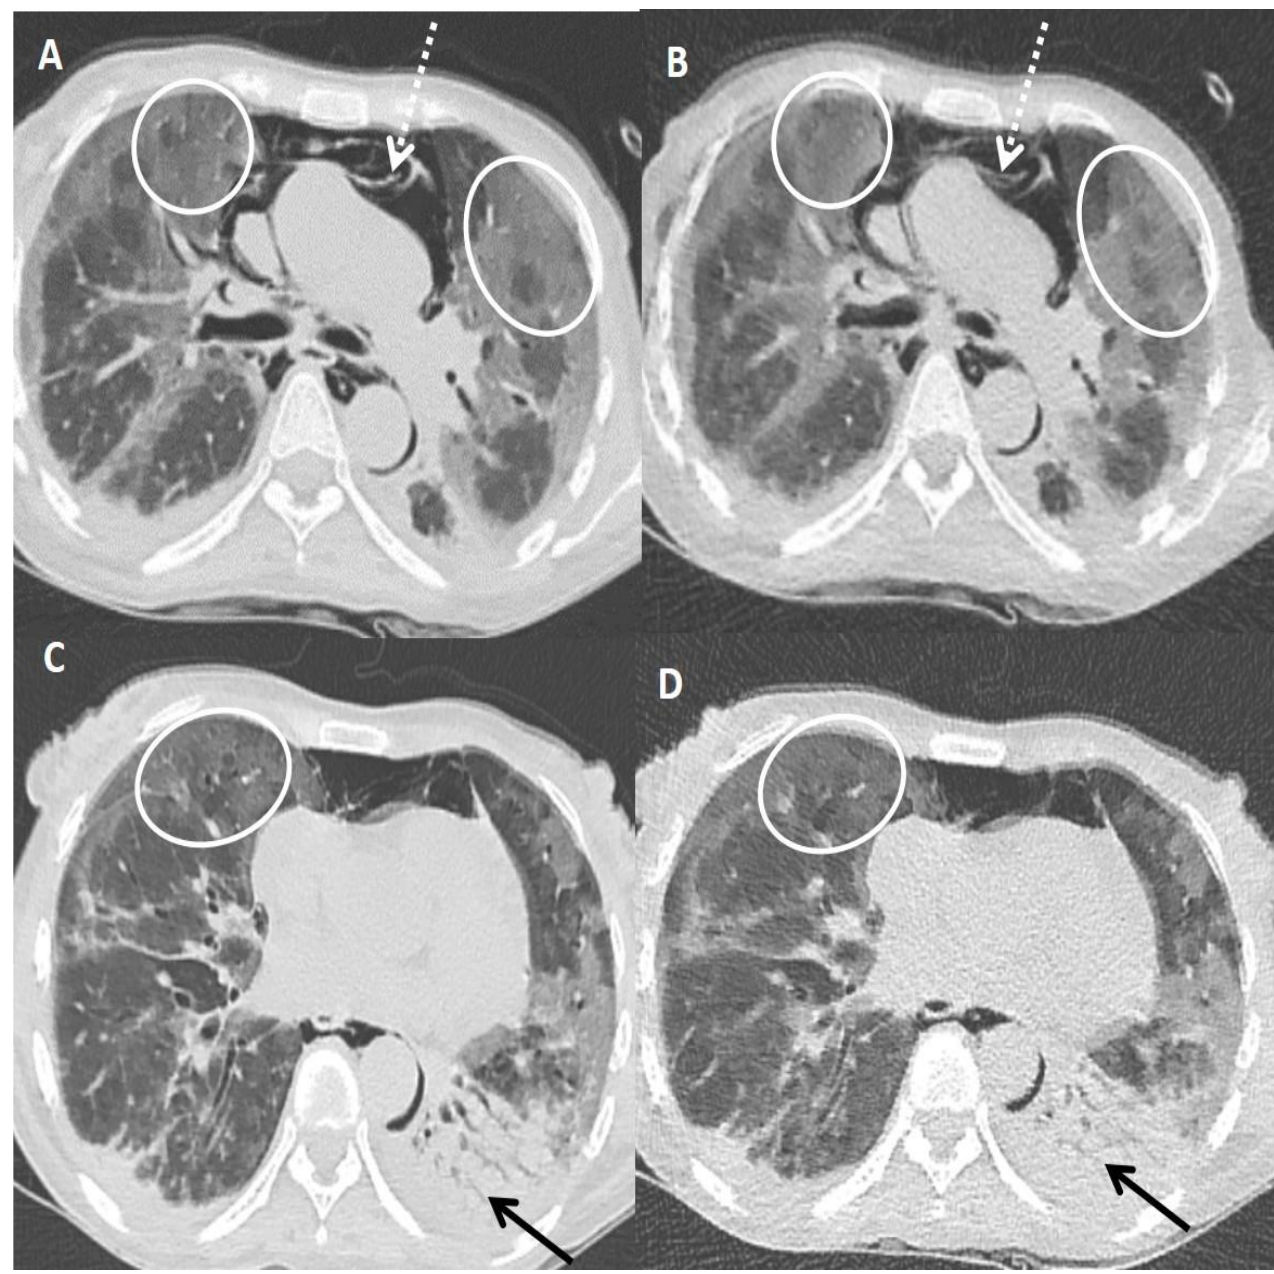
Figure 3. A 45-years old female patient tested positive for COVID-19. Standard dose CT (SDCT) chest ( A , C ) and corresponding ultra-low dose CT (ULDCT) chest ( B , D ) showing areas of GGOs (white circles) and patchy consolidation with air bronchogram (black arrows). Pneumomediastinum was also seen (dotted white arrows). The effective radiation dose for SDCT and ULDCT was 4.13 mSv and 0.25 mSv, respectively, while the CT severity score calculated on both SDCT and ULDCT was similar (19/25).